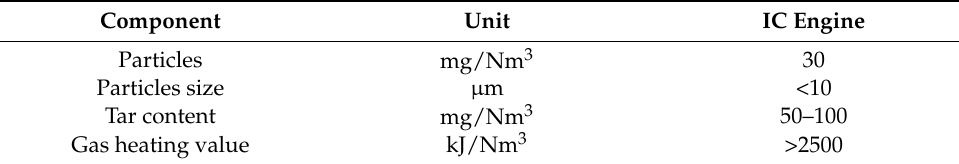
Table 3. Gas quality requirements for internal combustion engines [29,30].